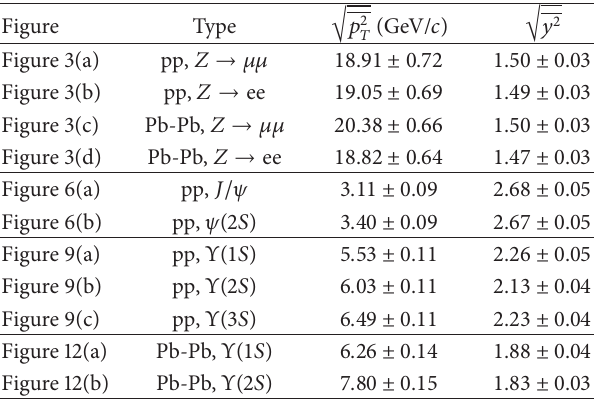
Table 3: Values of the root-mean-squares √ 𝑝 2 𝑇 for 𝑝 𝑇 and √𝑦 2 for 𝑦 corresponding to the particle scatter plots in Figures 3, 6, 9,